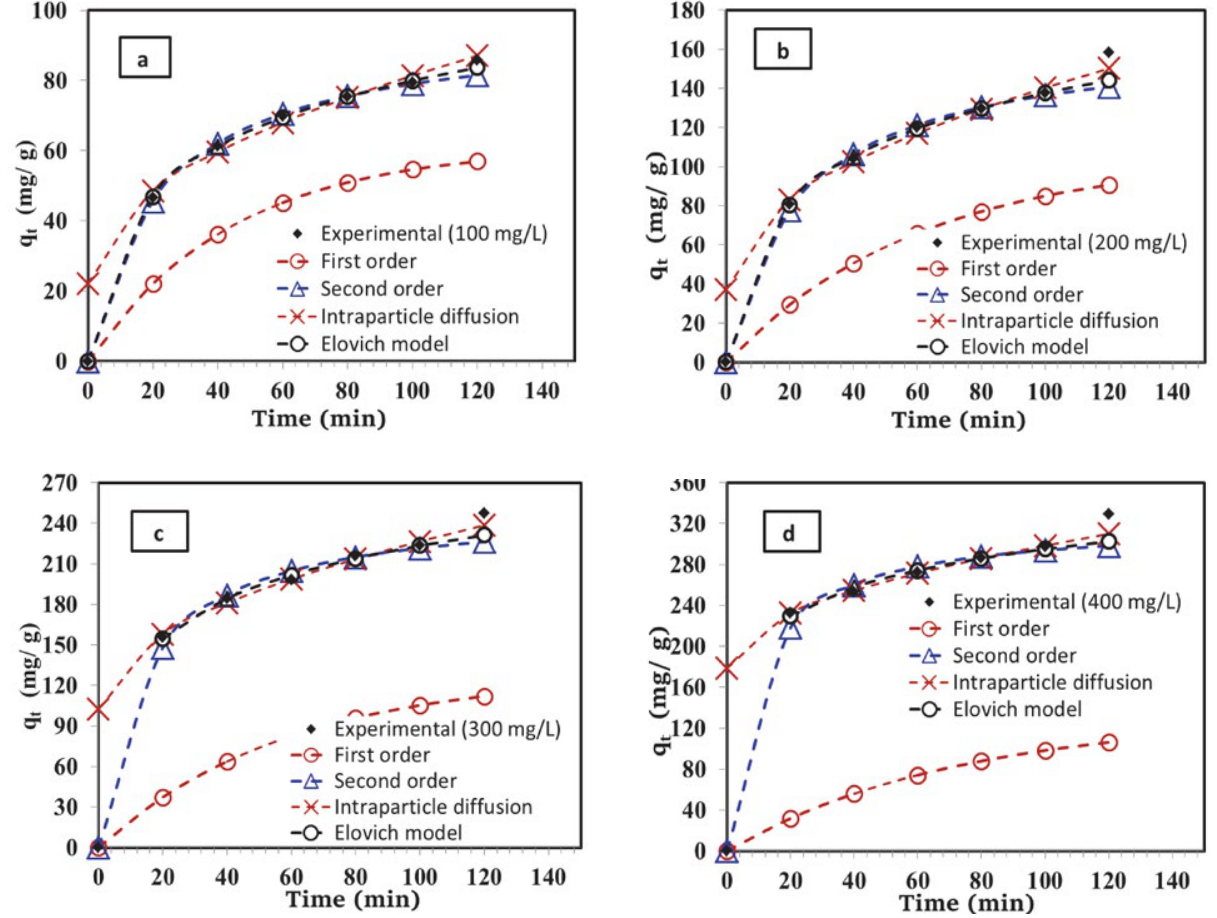
Figure 6. Comparison of experimental and calculated values obtained from the pseudo-first order, pseudo-second order, intraparticle diffusion and Elovich kinetic models (a–d).